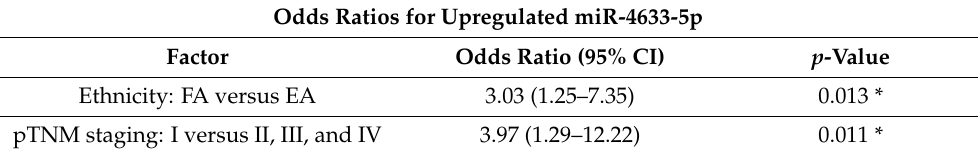
Table 6. Analysis of the upregulated miR-4633-5p among patients from different ethnicities and different pTNM staging.